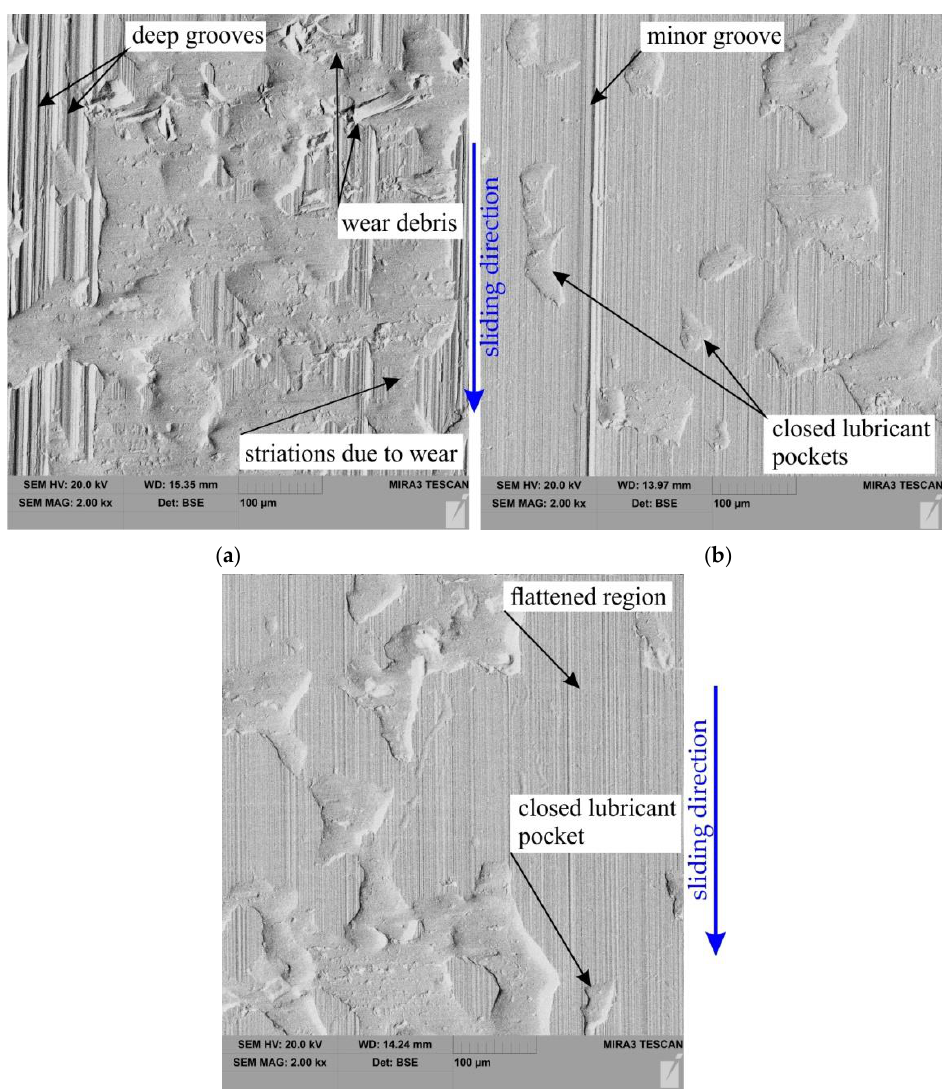
Figure 13. SEM micrographs of the sheet surface after friction tests carried out under the following conditions (nominal pressure p = 12 MPa): ( a ) dry friction, ( b ) 5W-30 oil and ( c ) 80W-90 oil.